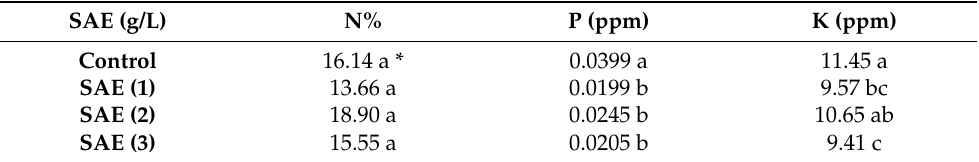
Table 8. Effects of Spirulina platensis aqueous extract (SAE) treatments on nitrogen (N), phosphorus (P) and potassium (K) percentage in Curcuma longa leaves.